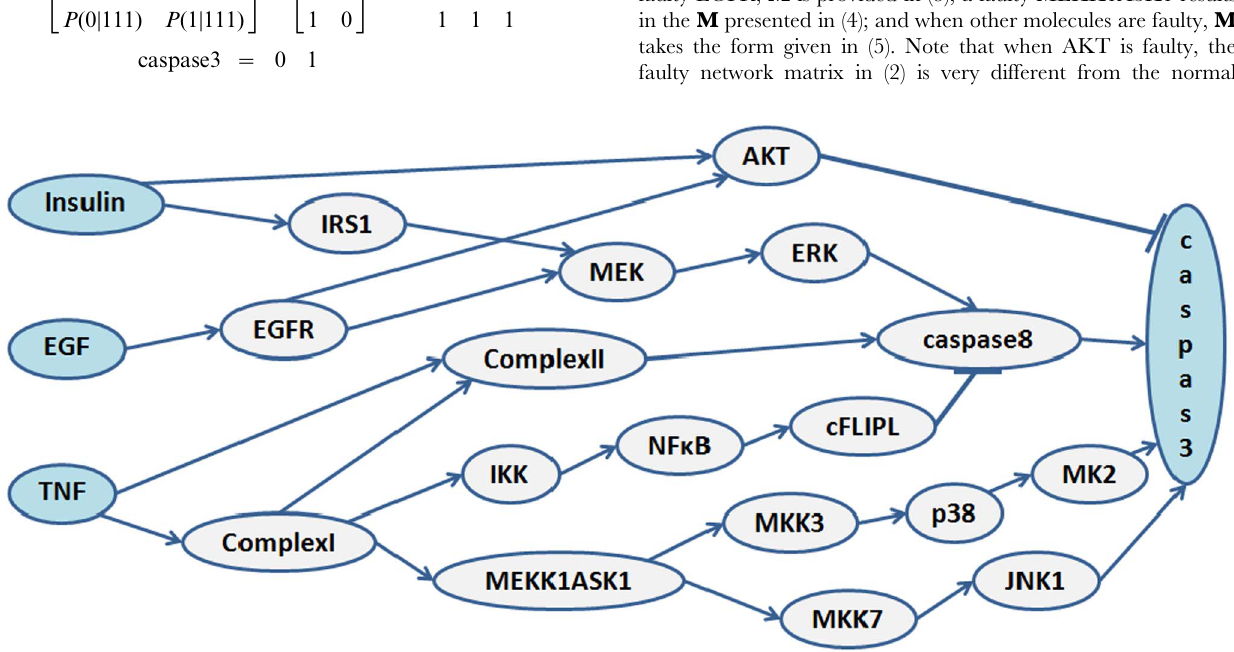
Figure 1. The caspase3 network. The three input molecules are insulin, EGF and TNF, which regulate the output molecule, caspase3, via some intermediate molecules.